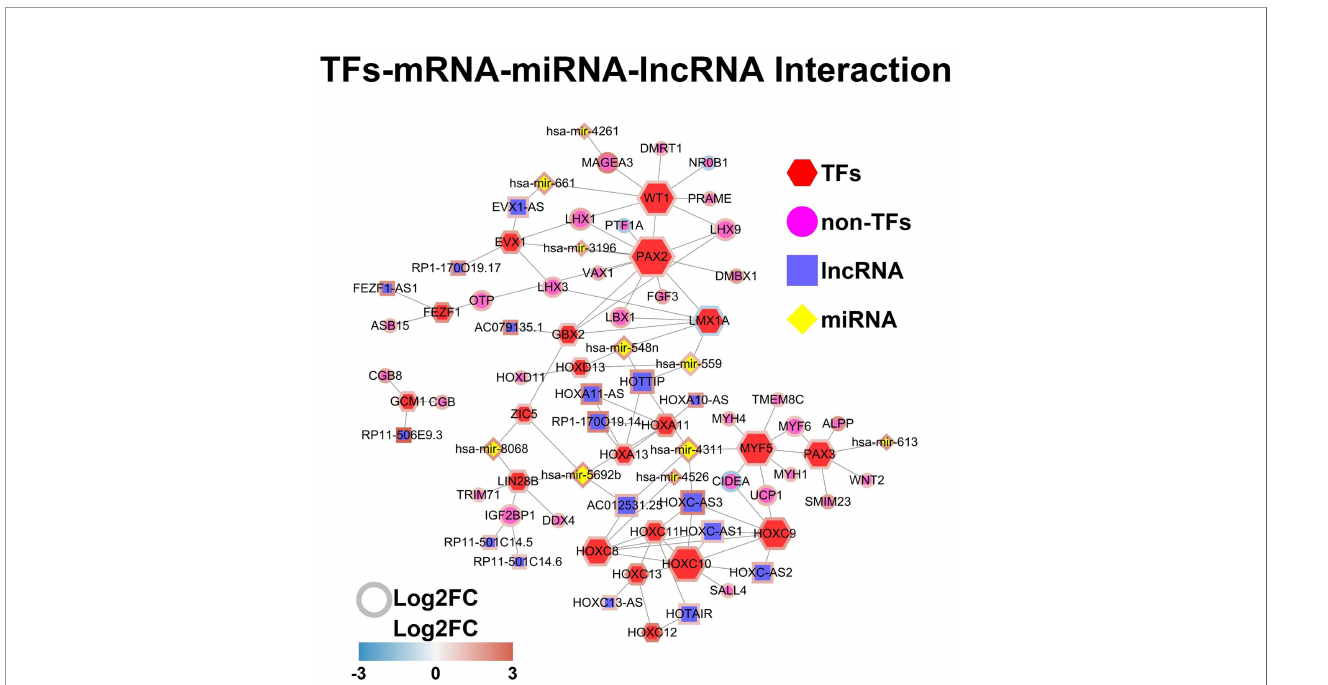
FIGURE 5 | TFs-mRNA-miRNA-lncRNA network. Each node represents one gene, and each edge represents the interaction between genes. TFs, non-TFs, lncRNAs and miRNAs are indicated using hexagon, circular, square and diamond shapes,